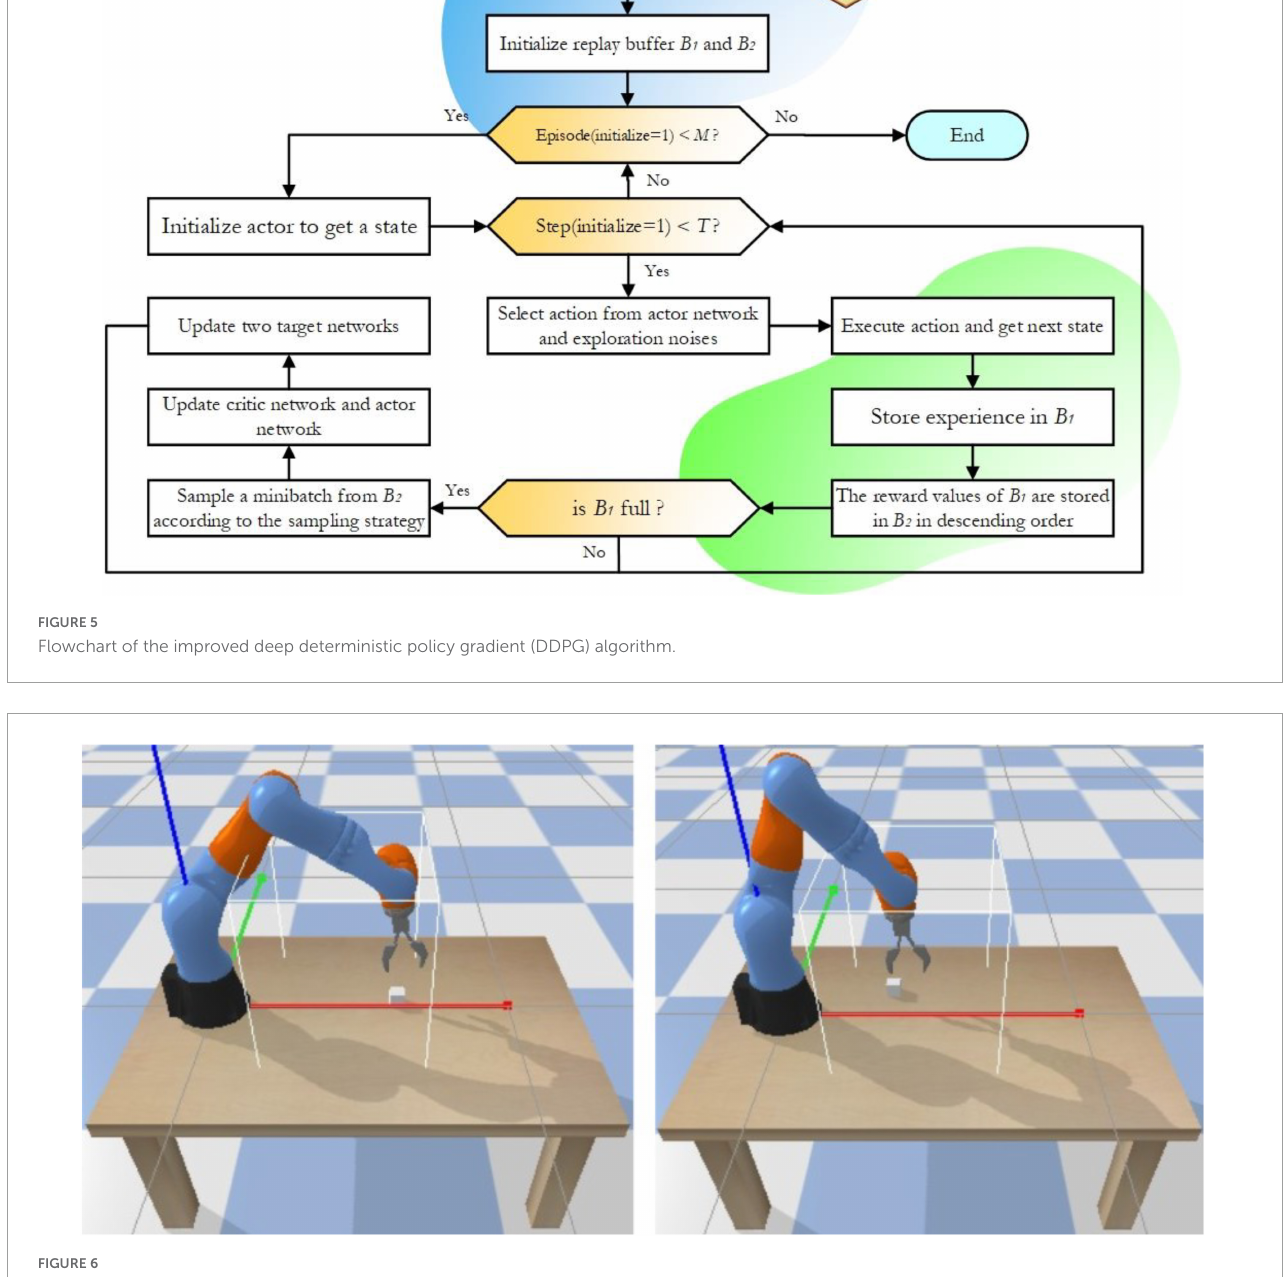
during the training. Figure 11 gives the convergence curves for the original and improved DDPG algorithms. The purple dotted line is the original DDPG algorithm; the green dotted line is the DDPG algorithm with improved reward, the red dashed line is the DDPG algorithm with improved experience pool, and the solid